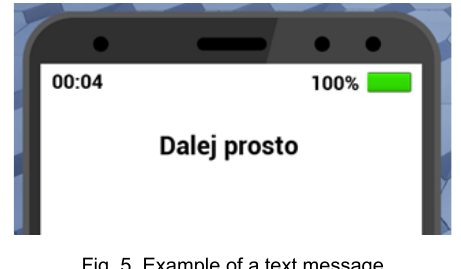
Fig. 5. Example of a text message (Message text: “Continue straight ahead”)